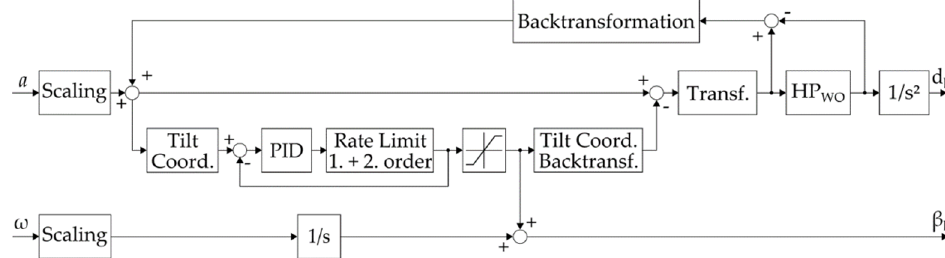
Figure 4. Structure of the proposed TBMCA.